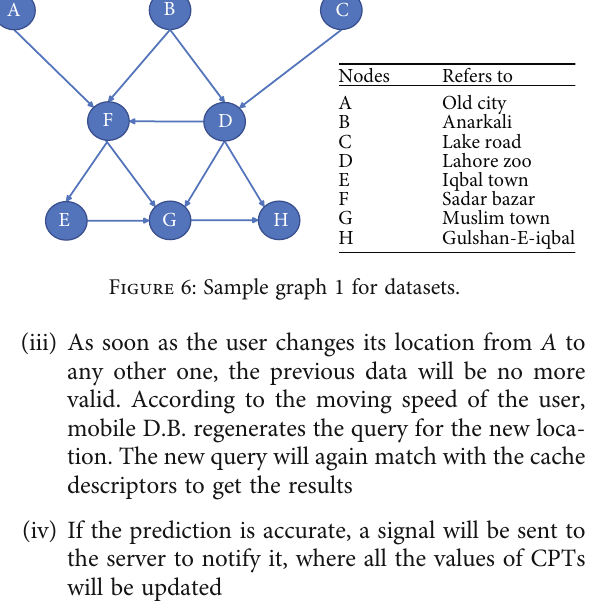
Table 2: Results of two graphs using Weka tool.